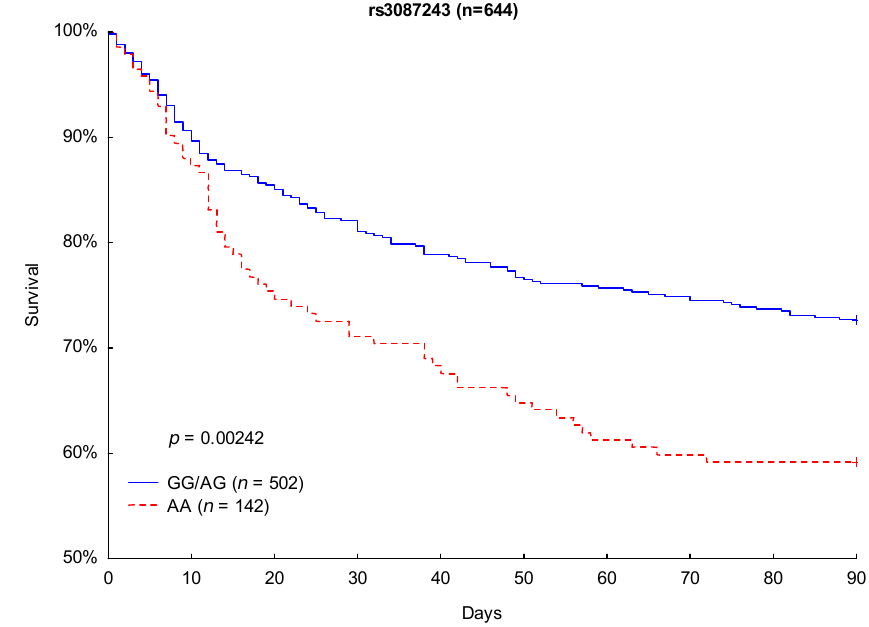
Figure 2. Kaplan–Meier survival analysis (90 days) with regard to the CTLA ‐ 4 rs3087243 genotypes.